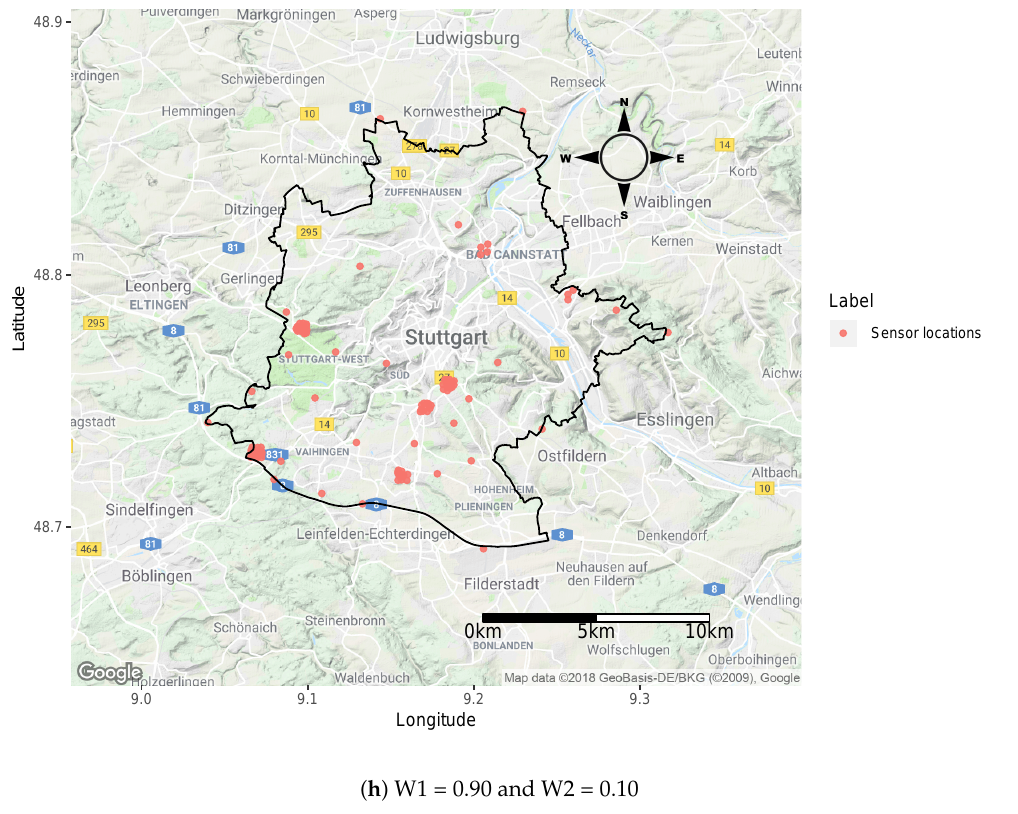
Figure A1. Configuration with various weights on prediction error (W1) and wide-spread (W2) aspect of developed objective function.